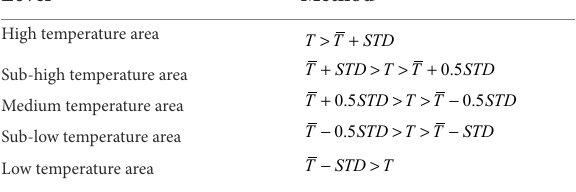
TABLE 2 The classification standard of